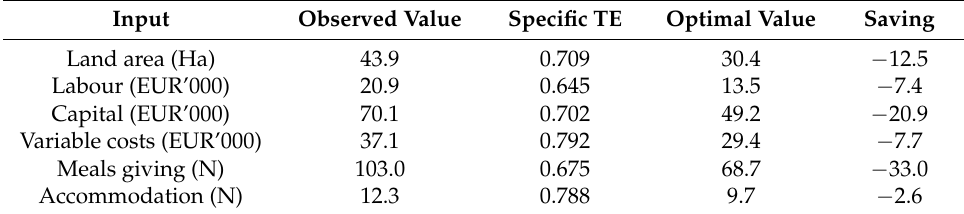
Table 6. Optimal (fully efficient) input use estimated by